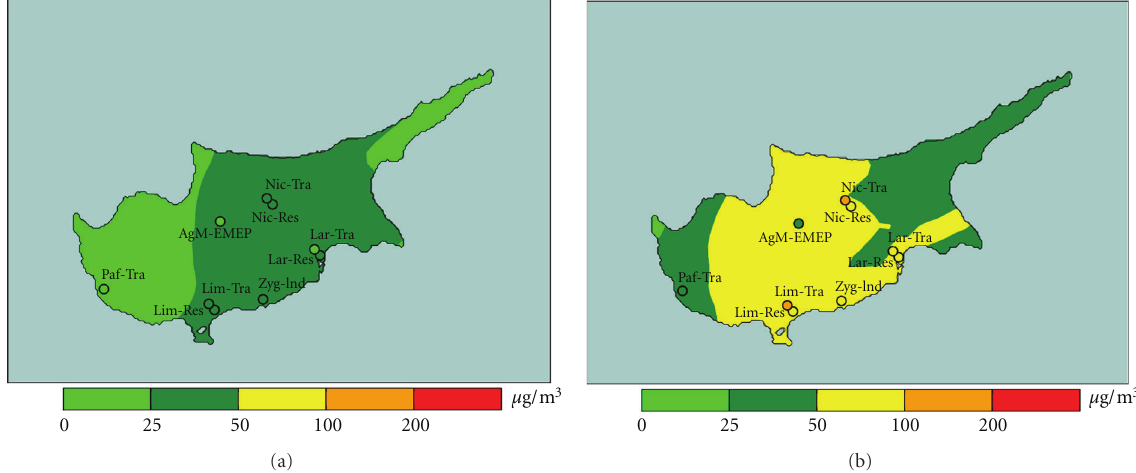
Figure 9: Validation maps as regards PM 10 for a typical winter day (a) and a day in which a slight Saharan dust episode occurs (b).